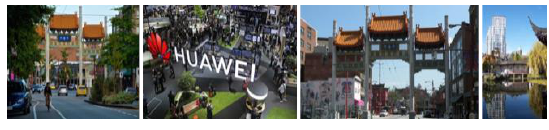
Figure 4. Rehabilitation at Hastings street.